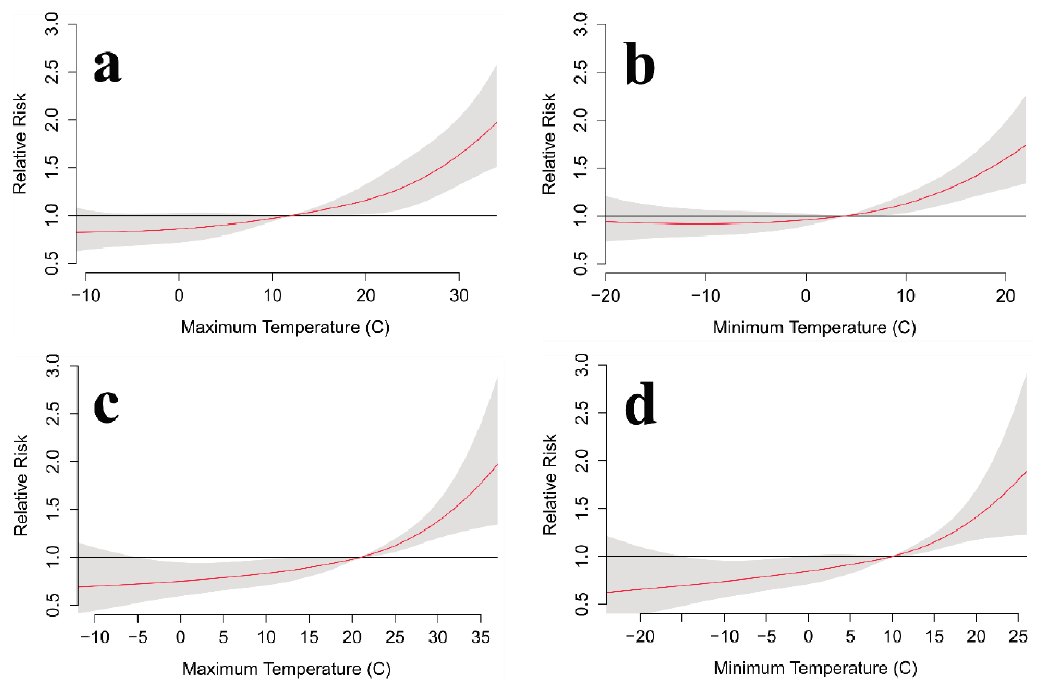
Figure 11. Toronto relative risk for suicide at various daily ( a , c ) maximum and ( b , d ) minimum temperatures over a 6-day lag for (a,b) the entire year and (c,d) the warm season (March–August). The red line is the predicted value and the gray shading represents the 95% confidence interval.